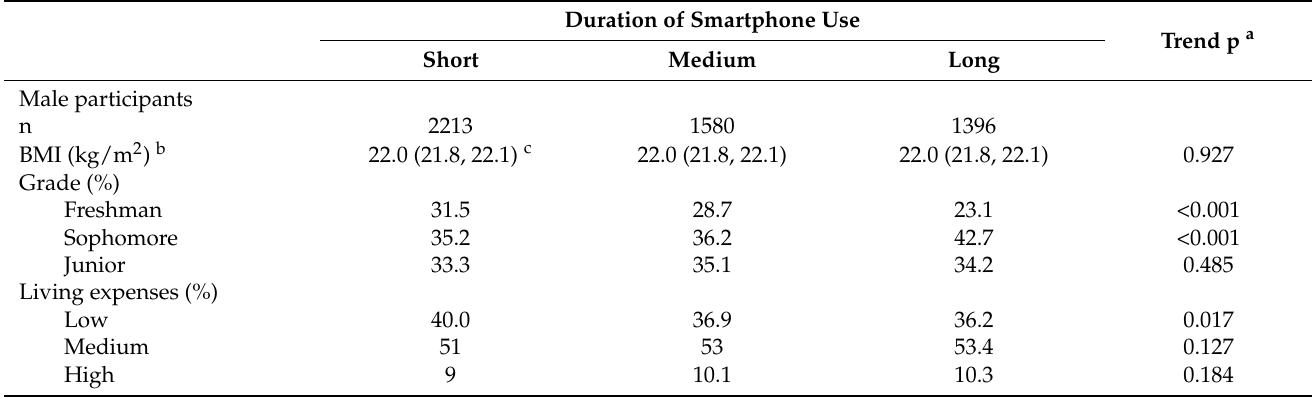
Table 2. Characteristics of male and female participants according to duration of smartphone